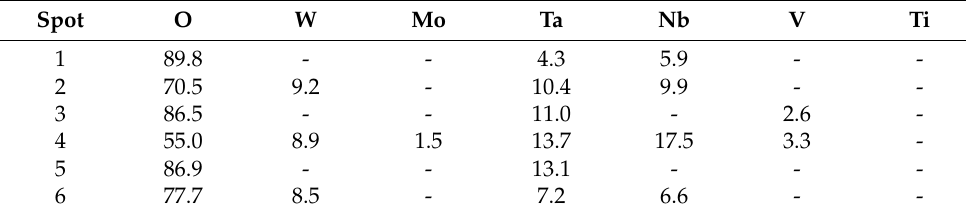
Table 4. Quantitative results for the EDS point analysis of the spots noted in Figure 4 (at %). Spot